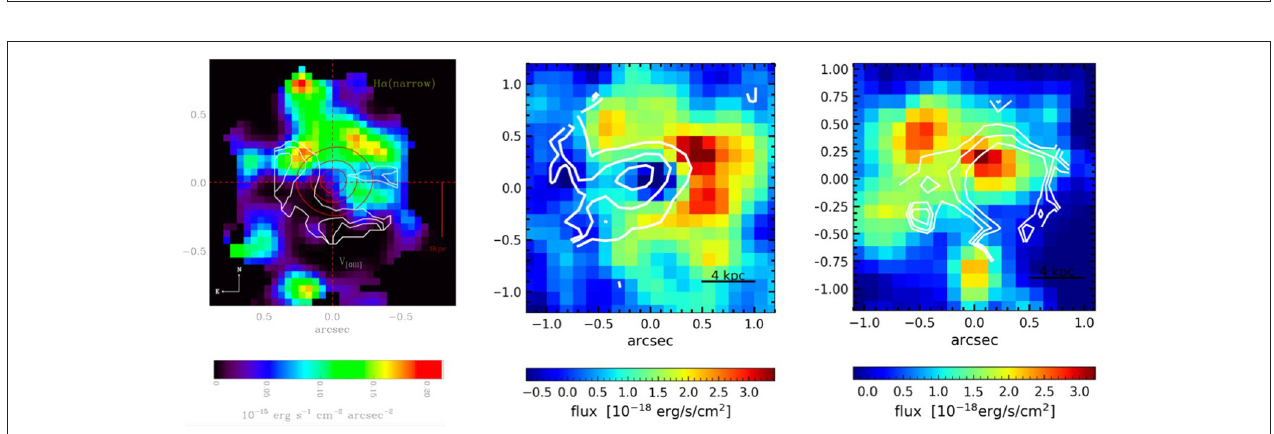
FIGURE 2 | Intensity map of narrow H α (left and middle) emission and [O III ] λ 5007 (right) emission for the three quasars showing ionized outflow anti-correlated with the star formation: 2QZ J0028–2830 from Cano-Díaz et al. (2012), HB89 0329 − 385 and LBQS 0109 + 0213 from Carniani et al. (2015, 2016). The stamps are 1 ′′ × 1 ′′ , 1.2 ′′ × 1.2 ′′ , and 1.2 ′′ × 1.2 ′′ , respectively for the three sources. The white contours in both maps trace the blue shifted [O III ] λ 5007 velocities of the broad component tracing the ionized outflow. The contours represent the velocities − 390, − 360, and 330 km/s for 2QZ J0028–2830, − 150, 100, − 50 km/s for HB89 0329 − 38, and 300, 275, and 250 km/s for LBQS 0109 + 0213. Credit: Cano-Díaz, A&A, 537, L8, 2012, reproduced with permission © ESO; Carniani, A&A, 591, 28C, 2016, reproduced with permission ©